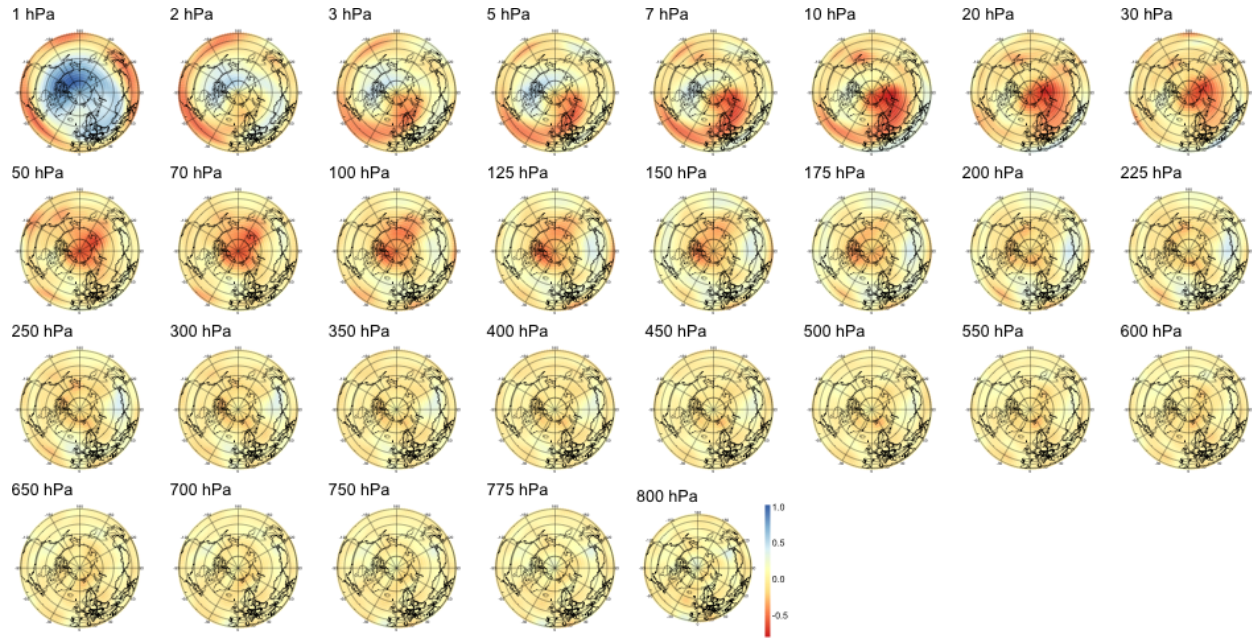
Figure B5. Pattern of PV anomalies maximizing correlation with the SSW index at a lead time of 60d.